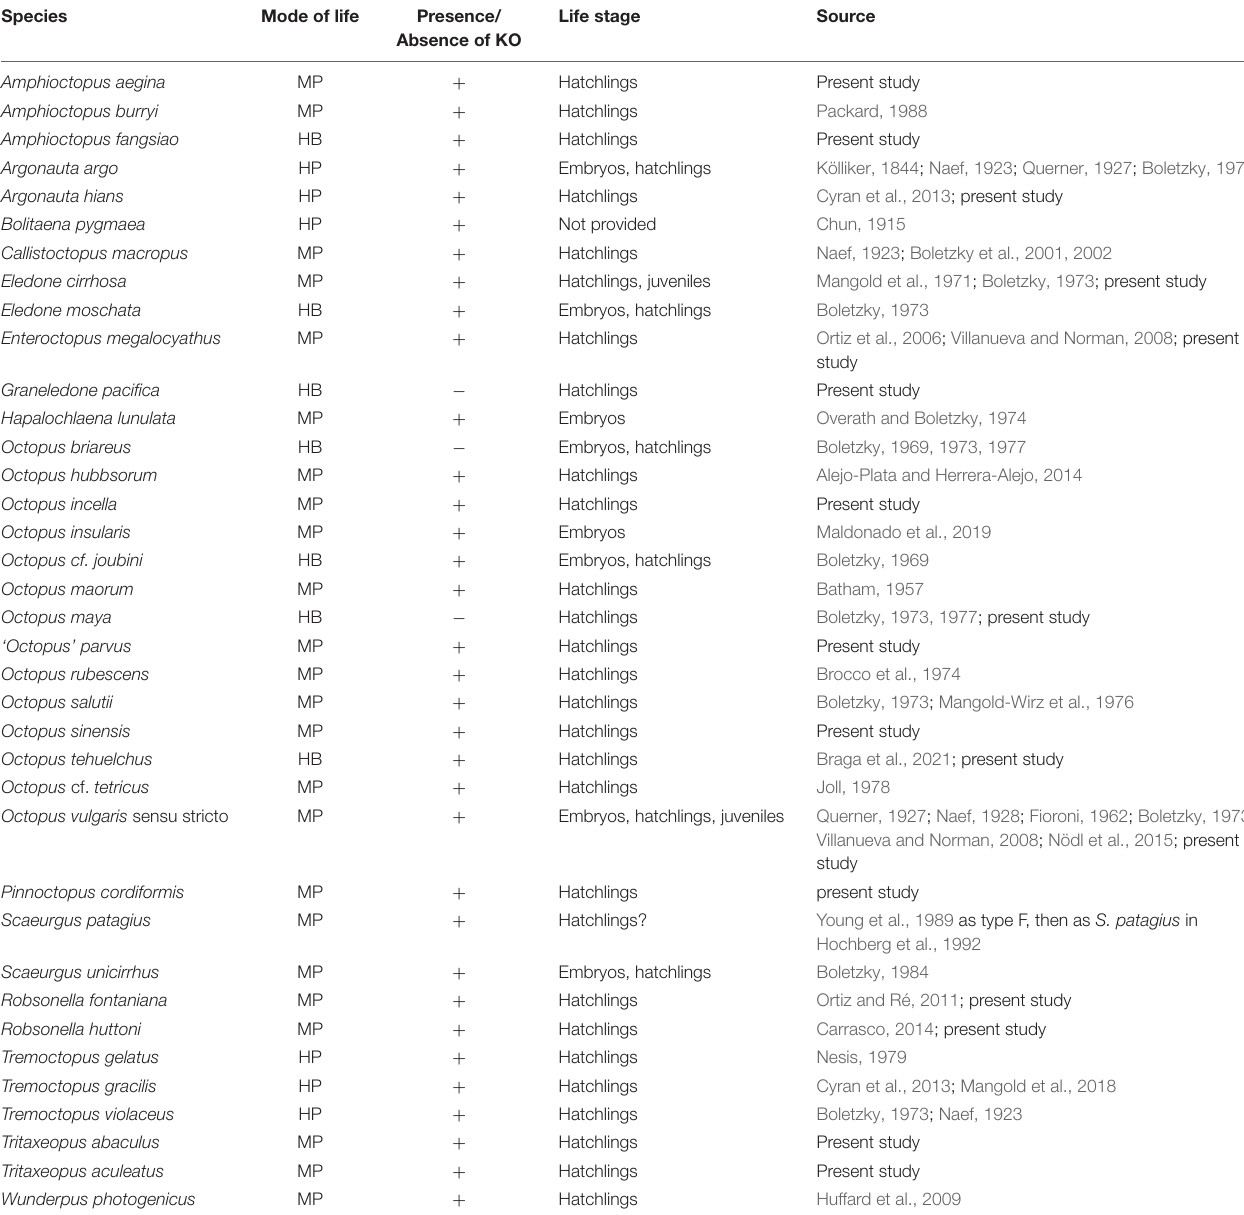
TABLE 1 | List of octopod species in which the presence or absence of Kölliker’s organs (KO) have been reported. Species Mode of